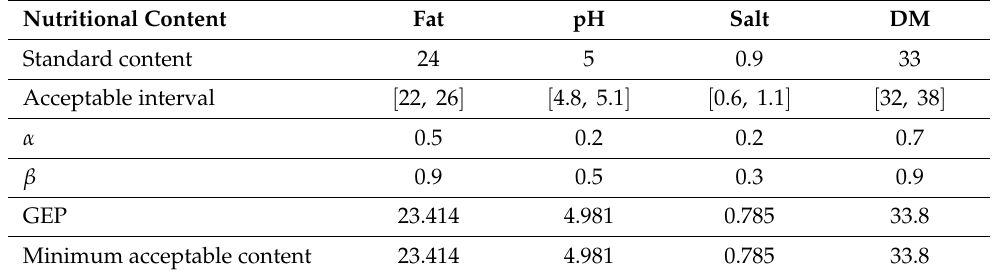
Table 12. The GEP of each nutritional content.